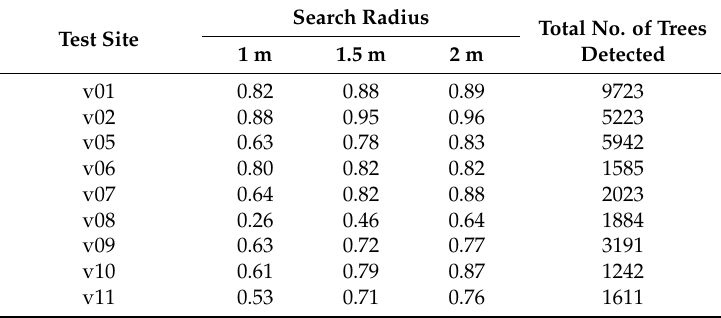
Table 18. Percentage of reference trees found using the individual tree detection method, and the total number of trees detected in each test site.